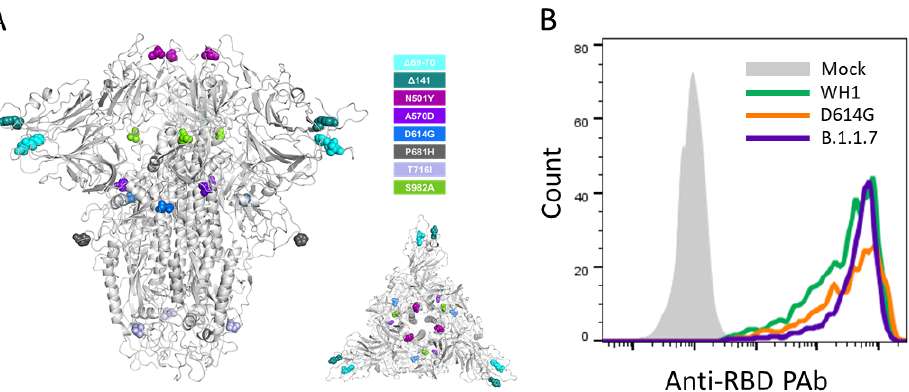
Figure 1. In vitro infectivity of SARS-CoV-2 variants. ( A ). The different mutations identified in the B.1.1.7 variant are listed and their location in the spike protein (side and top views) is shown. This variant also includes the D614G mutation. ( B ). Spike expression in pseudovirus-producing cells stained with an anti-RBD polyclonal rabbit antibody (See Methods for details).